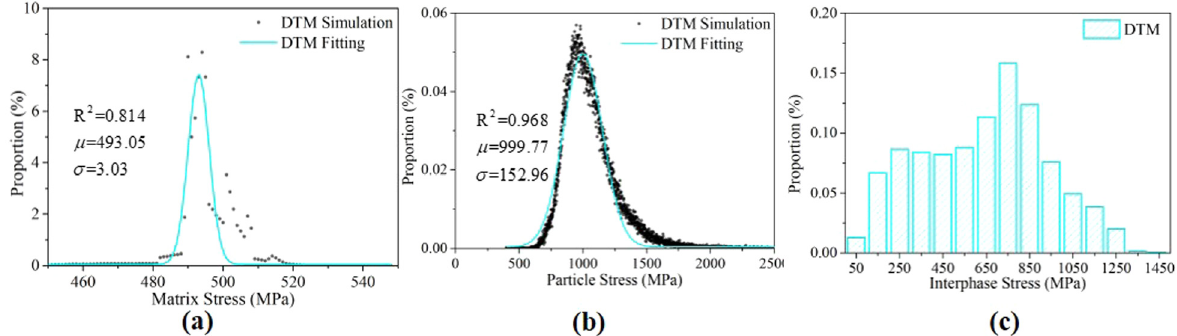
Figure 15: Micro - stress distribution with DTM nanoparticles at 1% strain: ( a ) matrix, ( b ) particle, and ( c ) interphase.